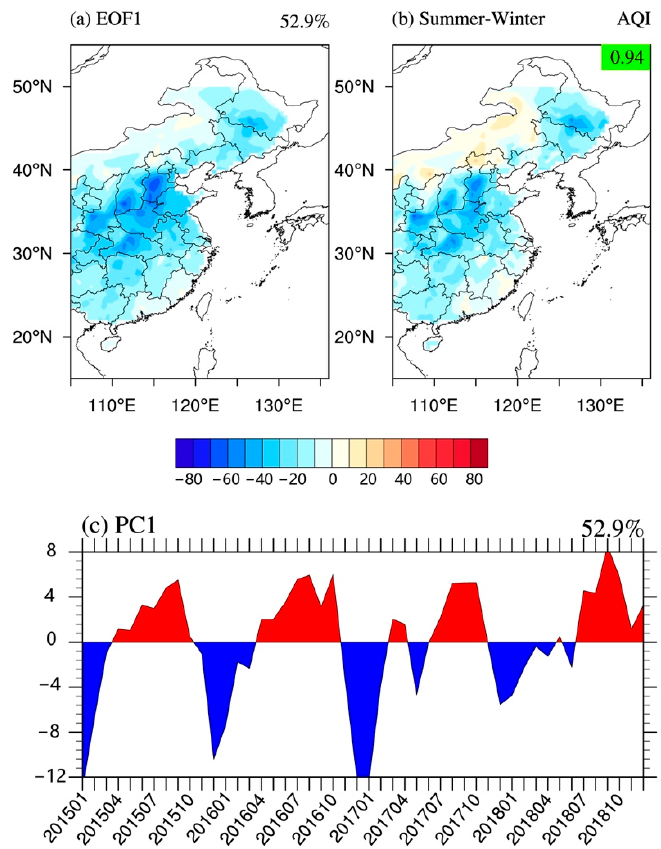
Figure 3. The leading EOF mode of the AQI variation in 2015–2018: ( a ) spatial structure (EOF1), ( c ) the corresponding principal component (PC1), and ( b ) spatial AQI distribution difference in the summer half year minus in winter half year. The fraction on the left top of panel ( a , c ) denotes the fractional explained variances of EOF1. The spatial correlation coefficients between ( a ) and ( b ) are shown at the top right corner of panel ( b ).